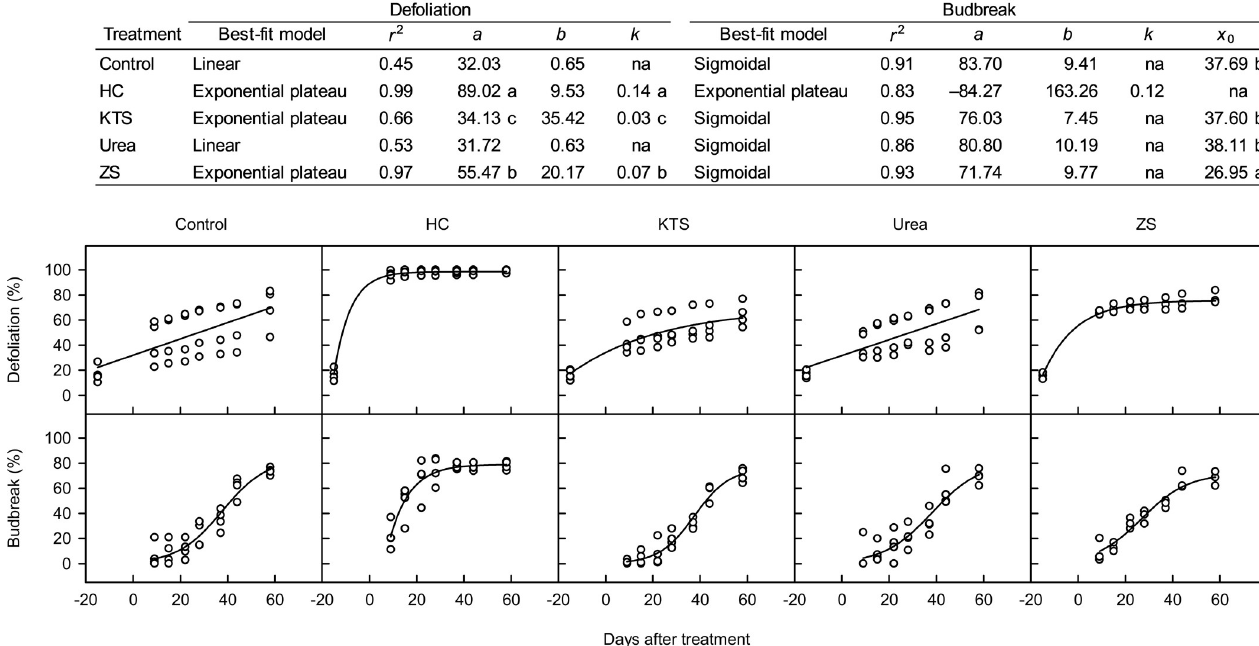
Fig 1. The best-fit model for temporal responses of defoliation and flower budbreak to hydrogen cyanamide (HC) and defoliants in ‘Emerald’ blueberry grown under inadequate chilling conditions in the 2018–2019 season (Expt. 1). Four models were fit to each data set: y = a + bx (linear), y = a + bx + cx 2 (quadratic), y = a + b [1 – exp (– kx )] (exponential plateau), and y = a /[1 + exp (–( x – x )/ b )] (sigmoidal). The best model was selected based on the smallest 0 corrected Akaike information criterion. When the same model was selected for more than two treatments, the model coefficients were compared between treatments using 95% confidence intervals. The model coefficients in a column followed by the same letter or no letter are not significantly different ( P < 0.05). KTS = potassium thiosulfate; ZS = zinc sulfate.